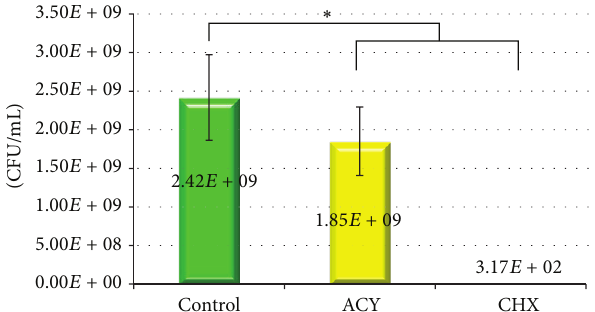
Figure 1: Survival of S. mutans (UA159) in response to treatment with Bis-GMA/TEGDMA-based resins containing ACY or CHX (CFU: colony forming units). The vertical bars denote average standard deviation; ∗ denotes statistical significance between groups ( 𝑃 < 0.05 ).